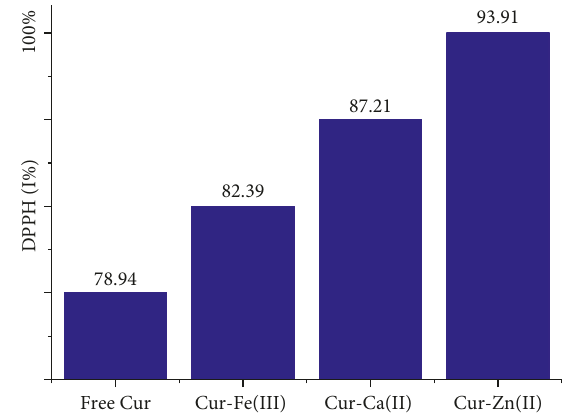
Figure 8: Antioxidant capacity (%) of curcumin complexes and free curcumin at the concentration of 100 μ g/ml.